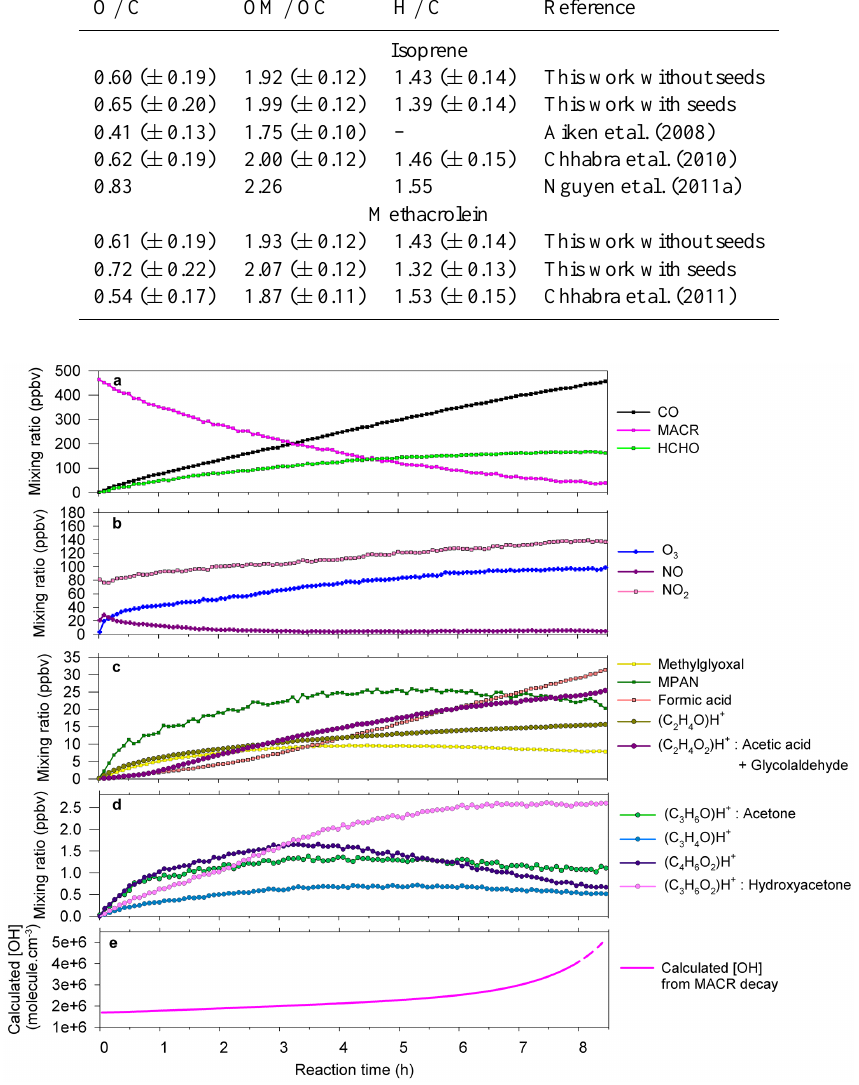
Figure 5. Time profiles of gas-phase measured compounds during MACR photooxidation (experiment M240512) performed without seed particles and with NO x as OH source. PTR-ToF-MS measurements are represented by circles, and FTIR measurements, by squares. Cal- culated [OH] is represented by a dotted line after 8h of irradiation due to low MACR mixing ratios which implies less precision in the calculation as the contribution from other VOCs is not